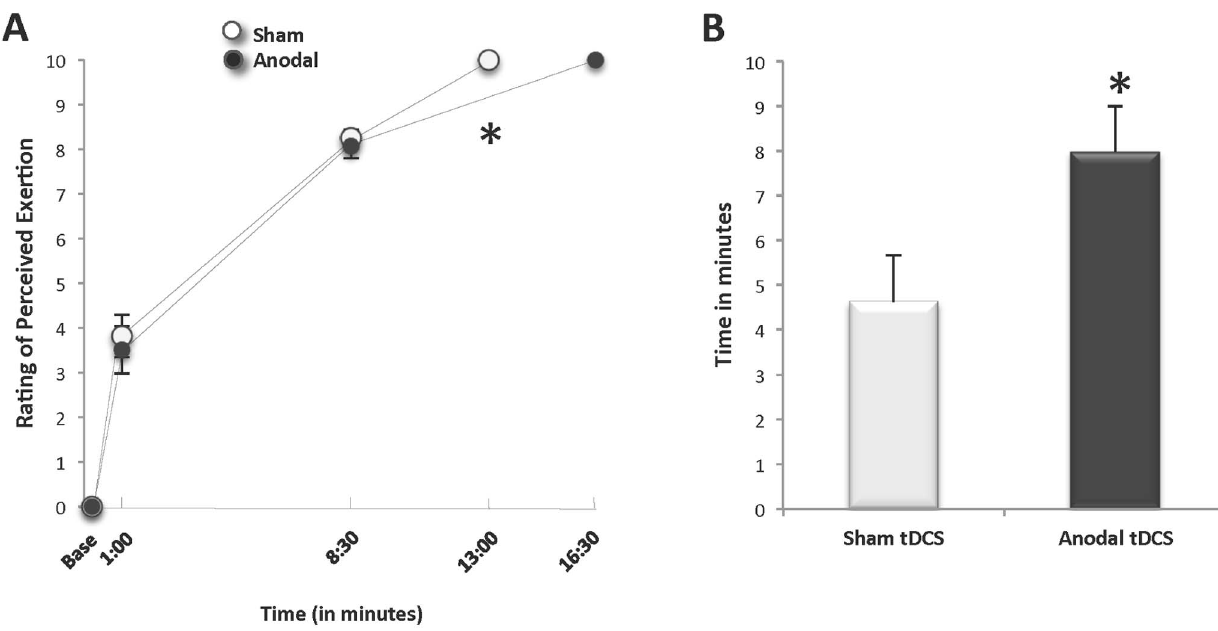
Figure 7. Effects of anodal tDCS on rating of perceived exertion during sustained contractions. A. Rating of perceived exertion (RPE), B. Amount of time spent at RPE of 8–10 (n=8). A. Mean RPE was the same before (baseline), during (minute-1:00 and minute-8:30), and at the mean time to task failure (TTF) of the fatiguing contraction for both the Anodal and Sham tDCS conditions. From baseline to minute-8:30, the mean increase in RPE over time did not differ between the two stimulation conditions. Between minute-8:30 and the mean TTF, the rate of change for RPE was significantly slower during Anodal tDCS condition than the Sham tDCS condition (* p =0.03). B. Subjects sustained their contraction time while at an RPE level between 8 and 10 for an average of 8.0 6 2.9 minutes with anodal stimulation compared to 4.6 6 2.9 minutes with sham stimulation (* p =0.04).